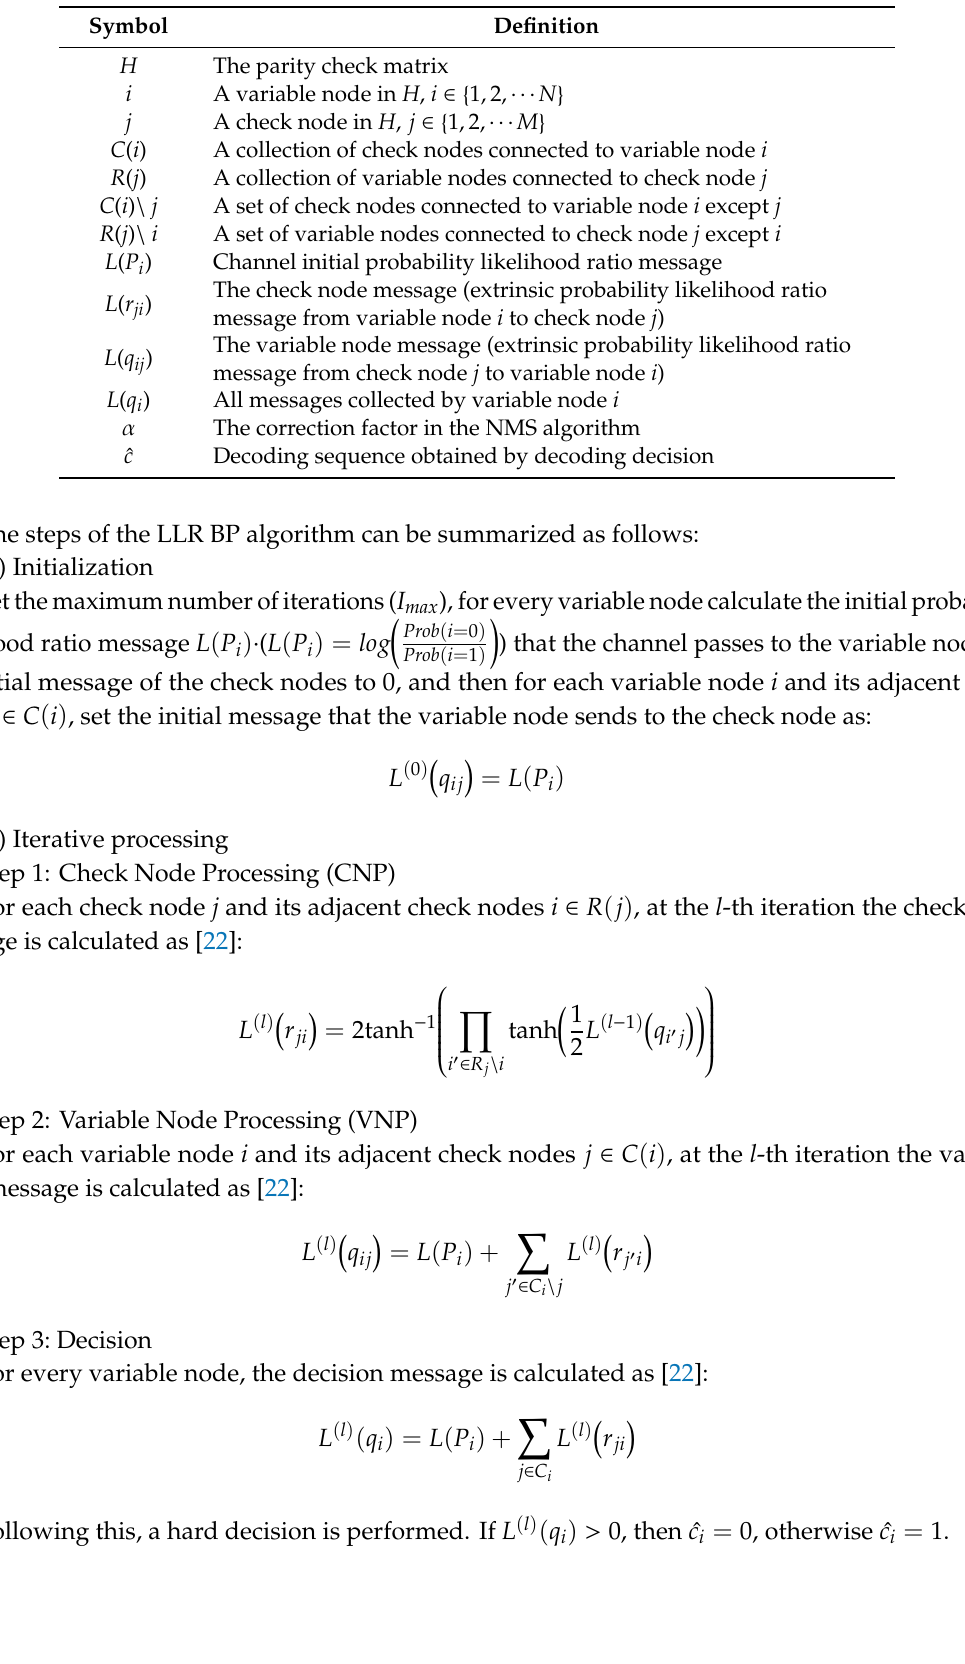
Table 1. Definitions of variable